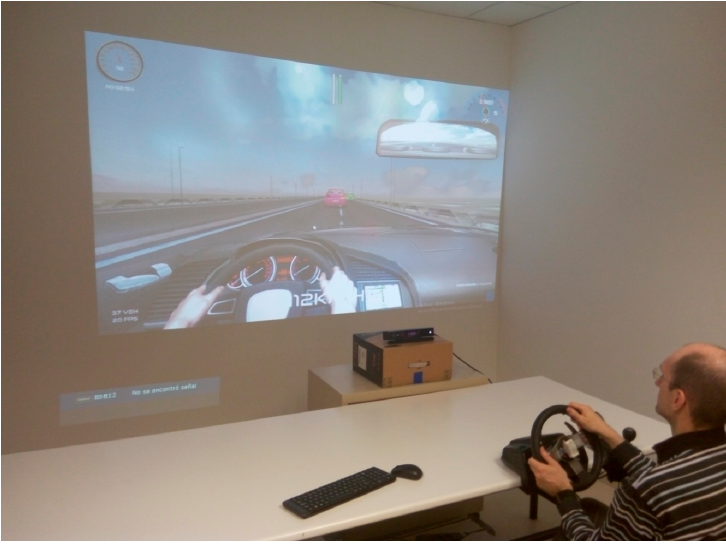
Figure 9. Driving simulator.